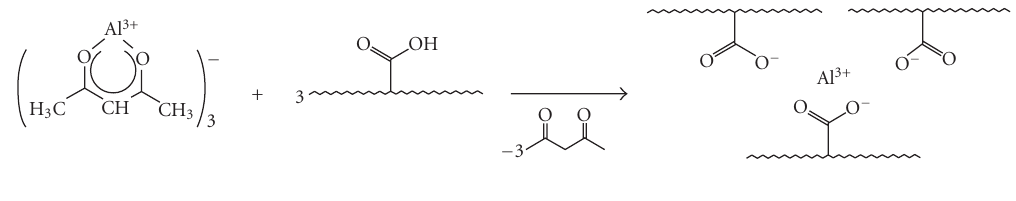
Figure 5: Schematic formation of ionical cross-linked membranes [23].